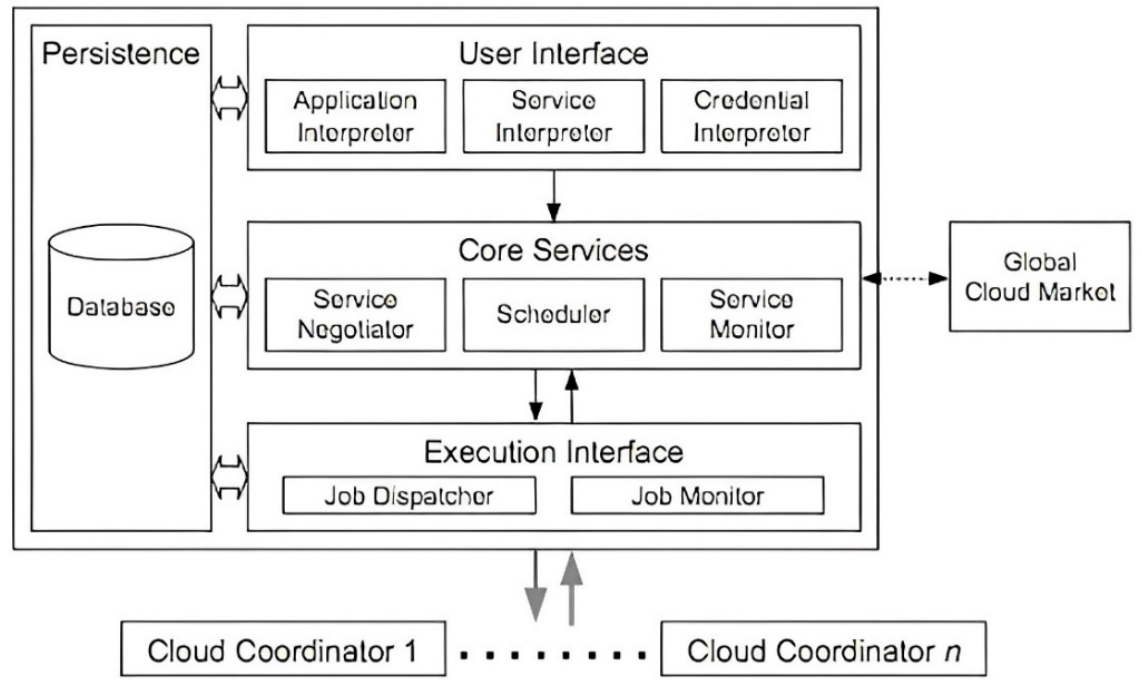
Figure 5. Cloud Service Broker Architecture